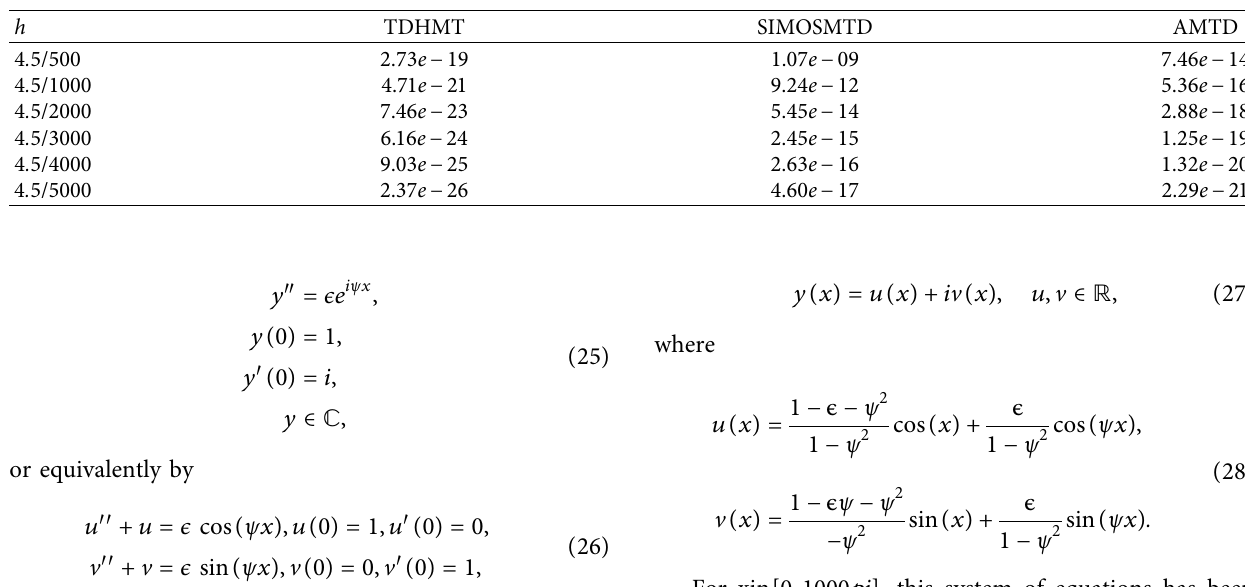
Table 4: Comparison of the absolute errors at the end point of TDHMTwith absolute error of other existing methods, namely, SIMOSMTD and AMTD for Example